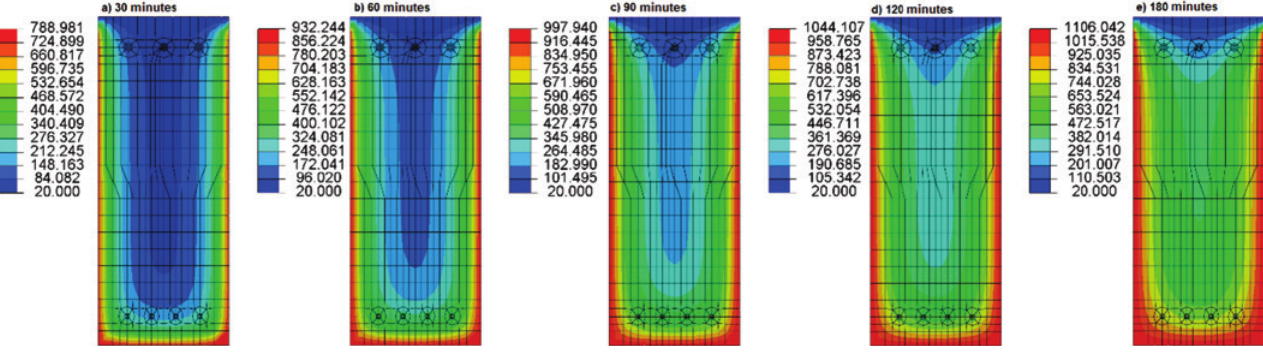
Figure 9 Isotherm B2-III for ratings of (a) 30, (b) 60, (c) 90, (d) 120, and (e) 180 minutes